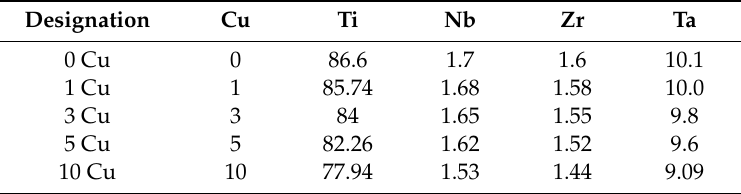
Table 3. Nominal weight percentages of elements in the TNTZ-Cu x alloys.